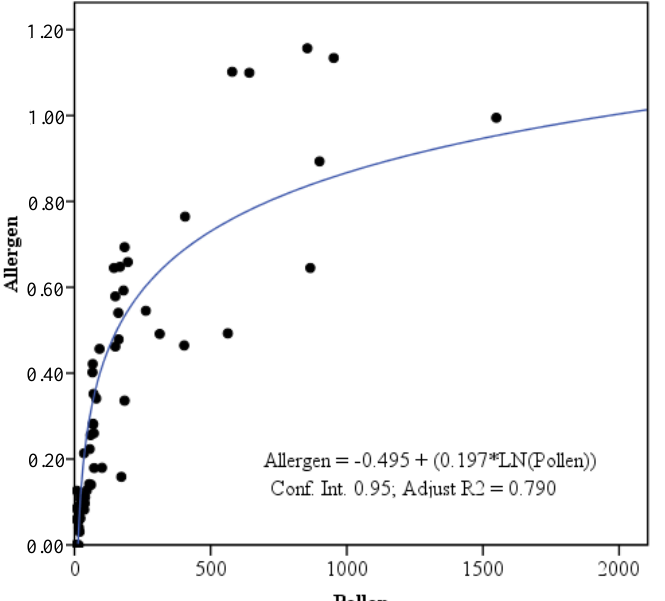
Figure 5. Platanus pollen concentrations (pollen/m 3 ) versus allergen values (ng/m 3 ) during the main pollen season in the study years.